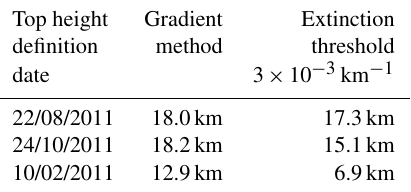
Table 6. Cloud top heights of the Nabro sulfate aerosol measured by the Leipzig lidar using the gradient method and the extinction threshold